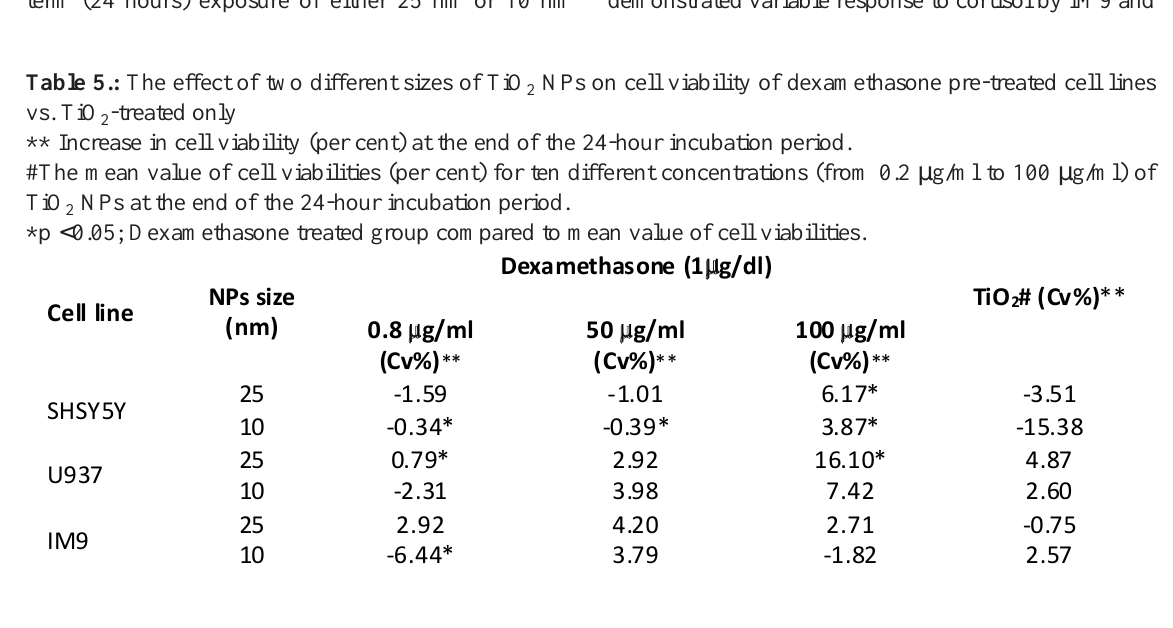
NPs on cell viability of dexamethasone pre-treated cell lines 2